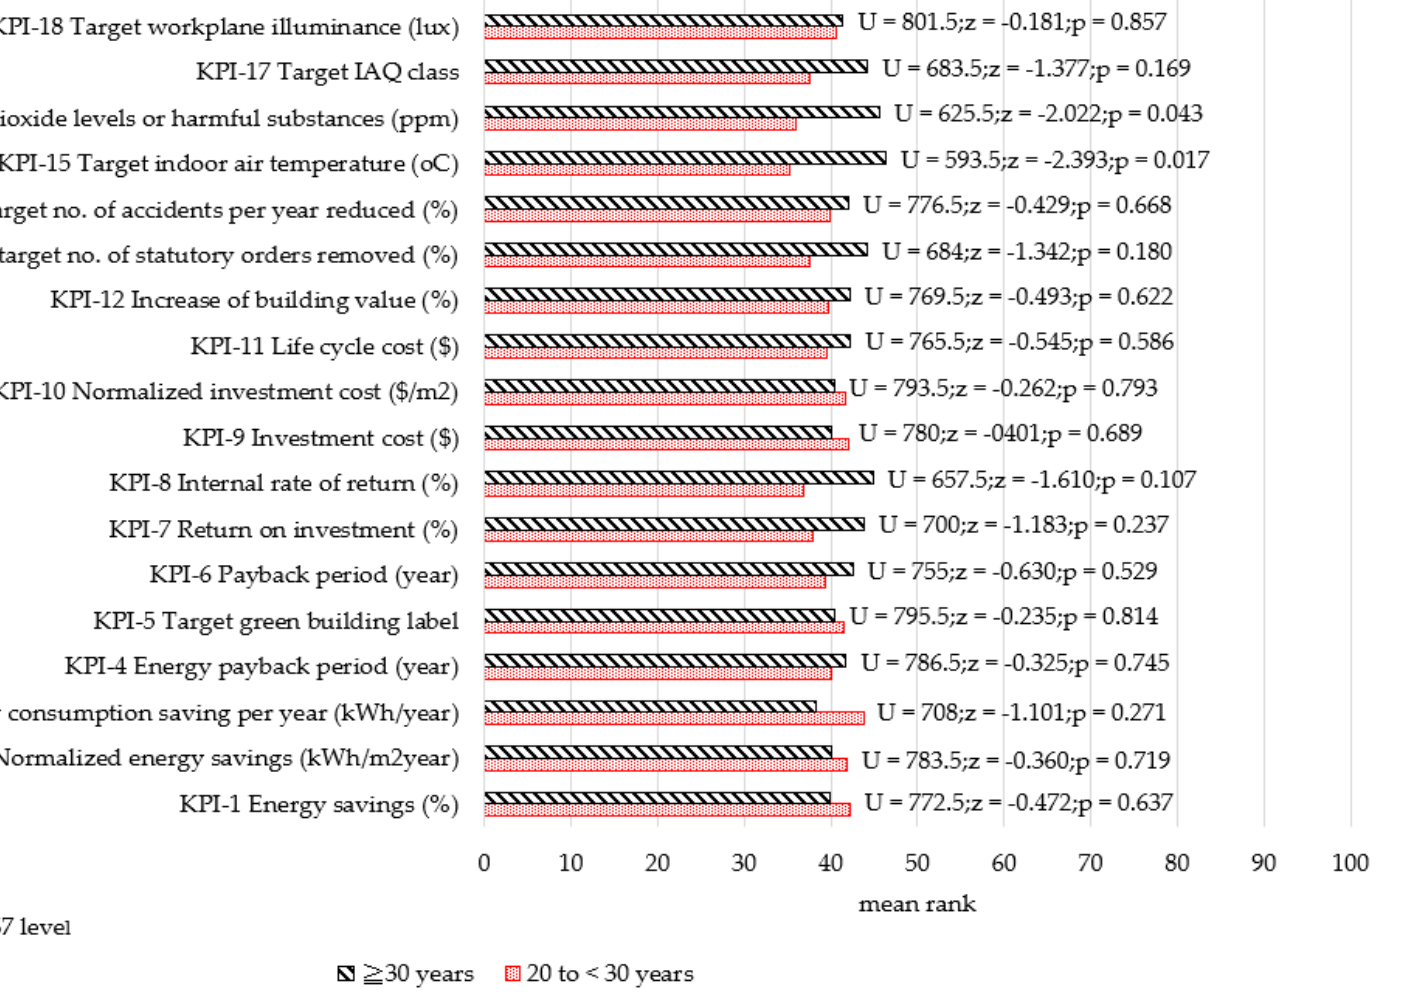
Figure A10. Mann – Whitney U-test results of G2 (work experience: G2c vs. G2d). Figure A10. Mann–Whitney U-test results of G2 (work experience: G2c vs.